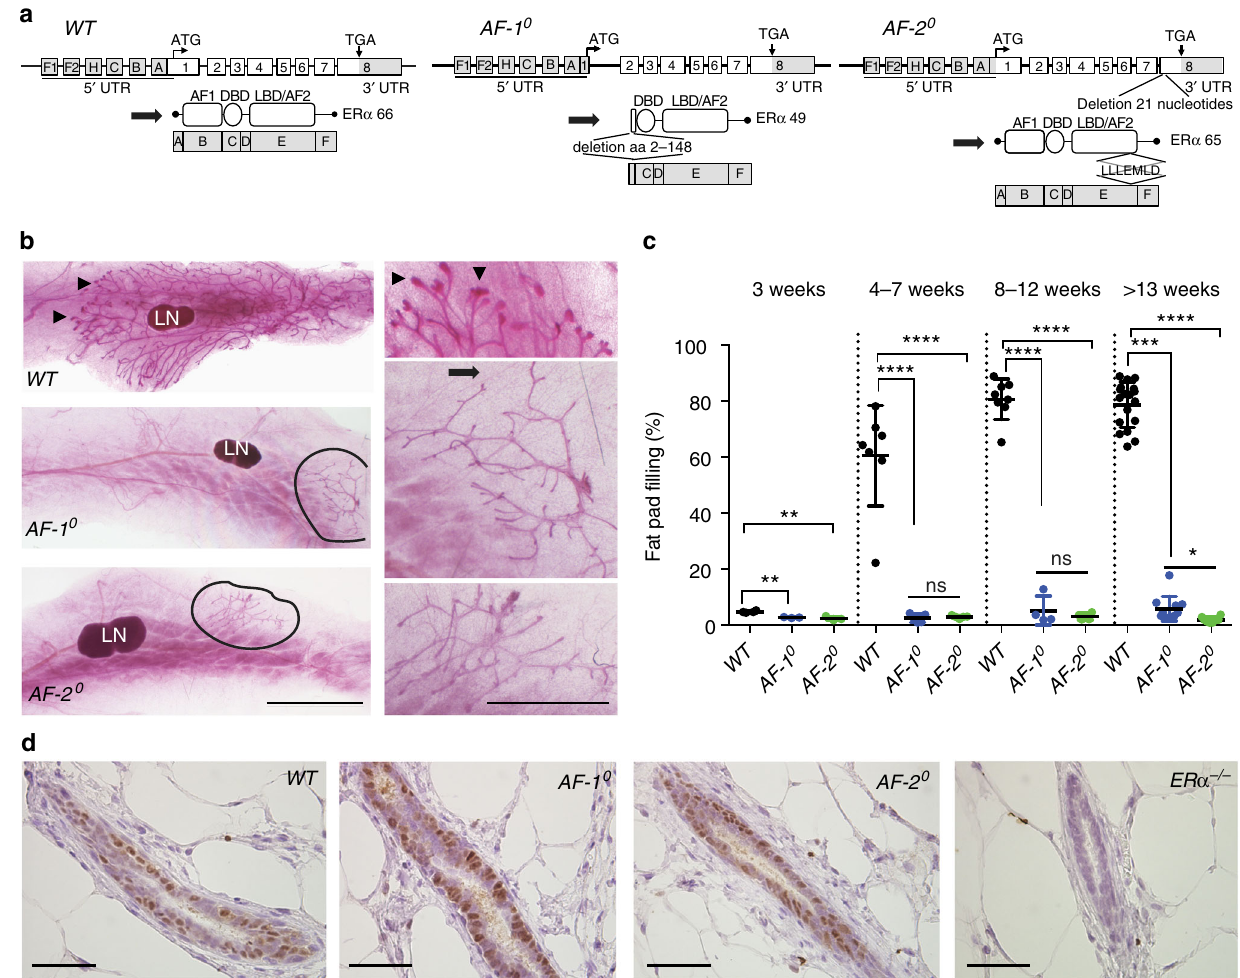
Fig. 1 Mammary gland phenotype of AF-1 0 and AF-2 0 mice. a Schematic representation of the mutant genomic loci and the ER α proteins expressed in WT mice, AF-1 0 mice with deletion of amino acids 2 – 148, and AF-2 0 mice with deletion of amino acids 543 – 549. Only the main protein initiated by the translational initiation codon in exon 1 on amino acid 1 (ATG) is shown for each genotype. The less abundantly expressed protein is initiated in exon 2 on amino acid 178. b Whole-mount stereomicrographs of inguinal mammary glands from 7-week-old WT , AF-1 0 and AF-2 0 females. Arrowheads indicate TEBs. Black lines mark the borders of the ductal outgrowth. Scale bars: 5 mm (left), 2 mm (right). LN sub-iliac lymph node. c Dot plot showing extent of fat pad area fi lled by the engrafted WT , AF-1 0 and AF-2 0 epithelia at different developmental stages ( n = 3 – 18). Shown are means ± SEM; unpaired, two-tailed, Student ’ s t test, * p < 0.05, ** p < 0.01, *** p < 0.001, **** p < 0.0001, n.s. not signi fi cant. d ER α IHC of mammary glands from 3-week-old WT , AF-1 0 , AF-2 0 and ER α − / − mice. Representative pictures of glands analysed from three females of each genotype are shown. Scale bar: 100